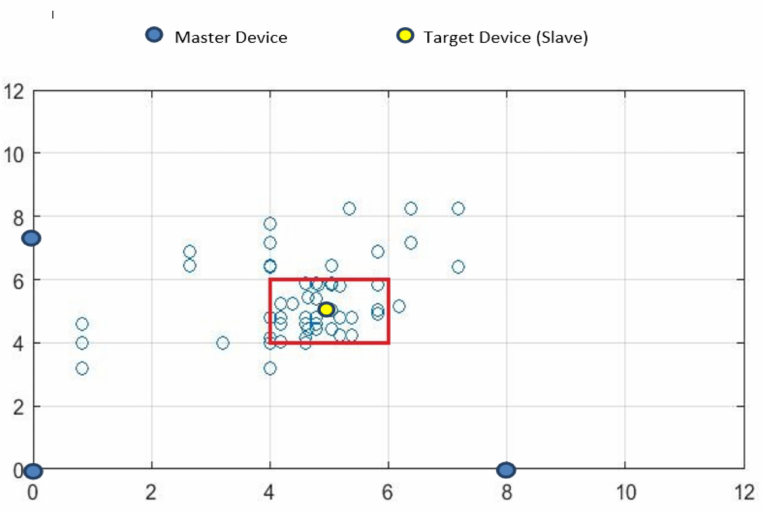
Figure 8. Test on zone (3;